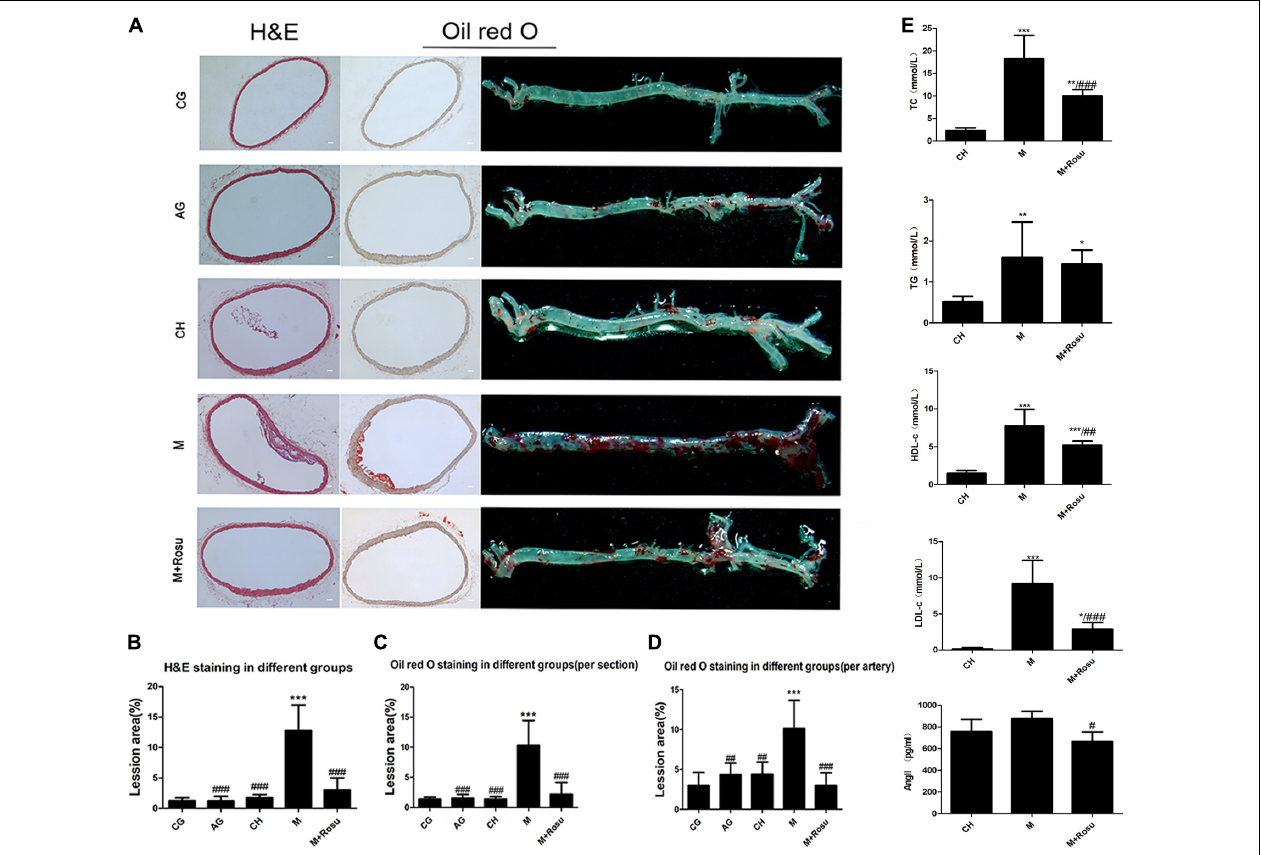
FIGURE 1 | The lesion degree of atherosclerosis and the effect of rosuvastatin in ApoE – / – mice. (A) HE pathological section, Oil red O pathological section, gross arterial tissue Oil red O staining. Scale bar: 50 µ m. (B–D) The relative lesion area of plaques was calculated by Image Pro Plus 6.0. (E) Concentration of lipids and Ang II in different animal groups. Data are shown as mean ± SD of at least three independent experiments. * P < 0.05, ** P < 0.01, *** P < 0.001 versus vehicle CH; # P < 0.05, ## P < 0.01, ### P < 0.001 versus vehicle model (M), one-way ANOVA. CG, C57BL/6J+general diet; AG, ApoE – / – +general diet; CH,